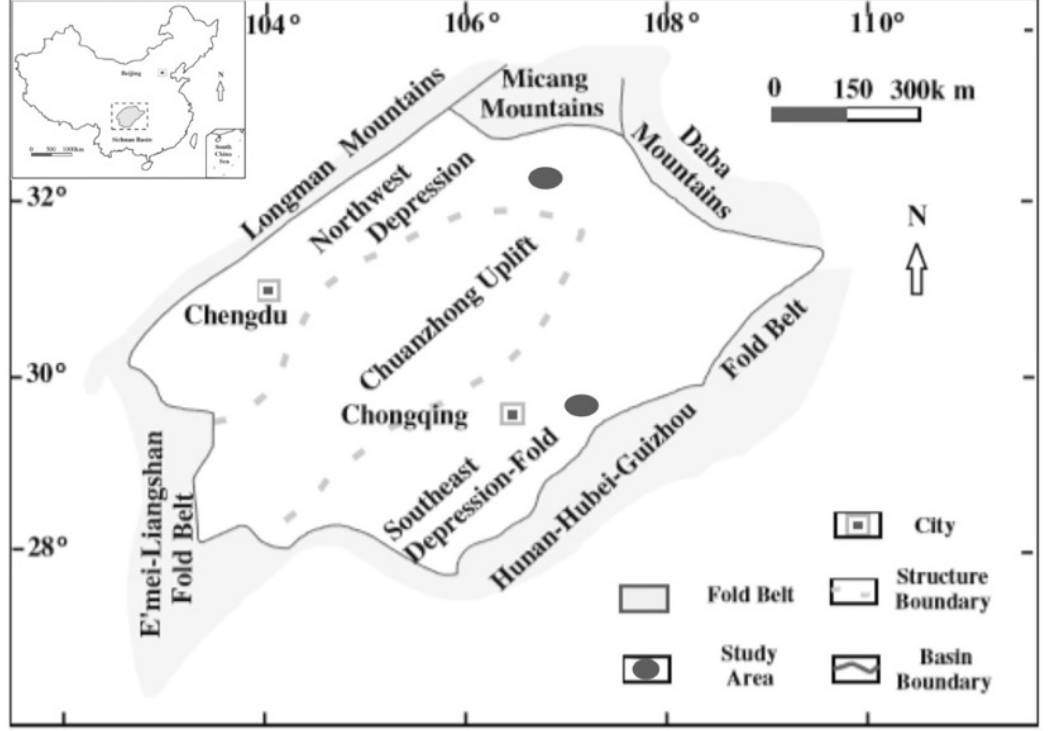
Figure 1. Locations of samples collected from the Sichuan Basin (modified from Wang et al. [32] and Liu et al. [33]).